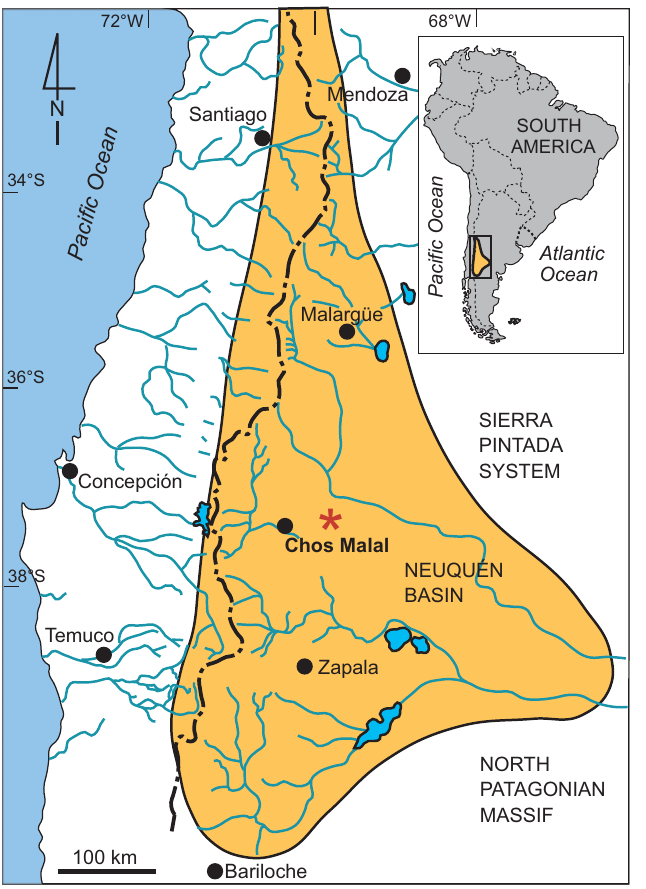
Fig. 1. Location map (based on Schwarz 2012), asterisk marks the study area within the Neuquén Basin (highlighted) while the inset refers to the location of the detailed map within South America.